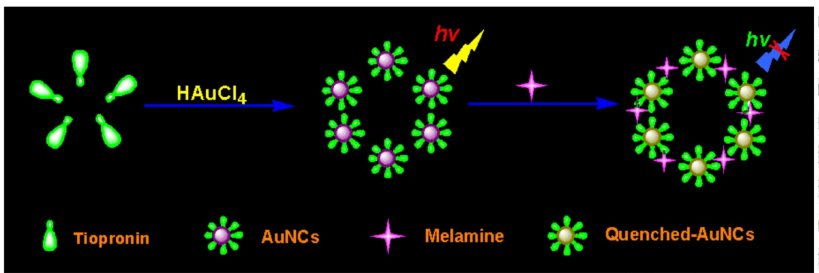
Figure 6. Scheme of the synthetic strategy for tiopronin-stabilized gold nanoclusters (TPN-AuNCs) and the principle of melamine sensing (reproduced with permission from Reference